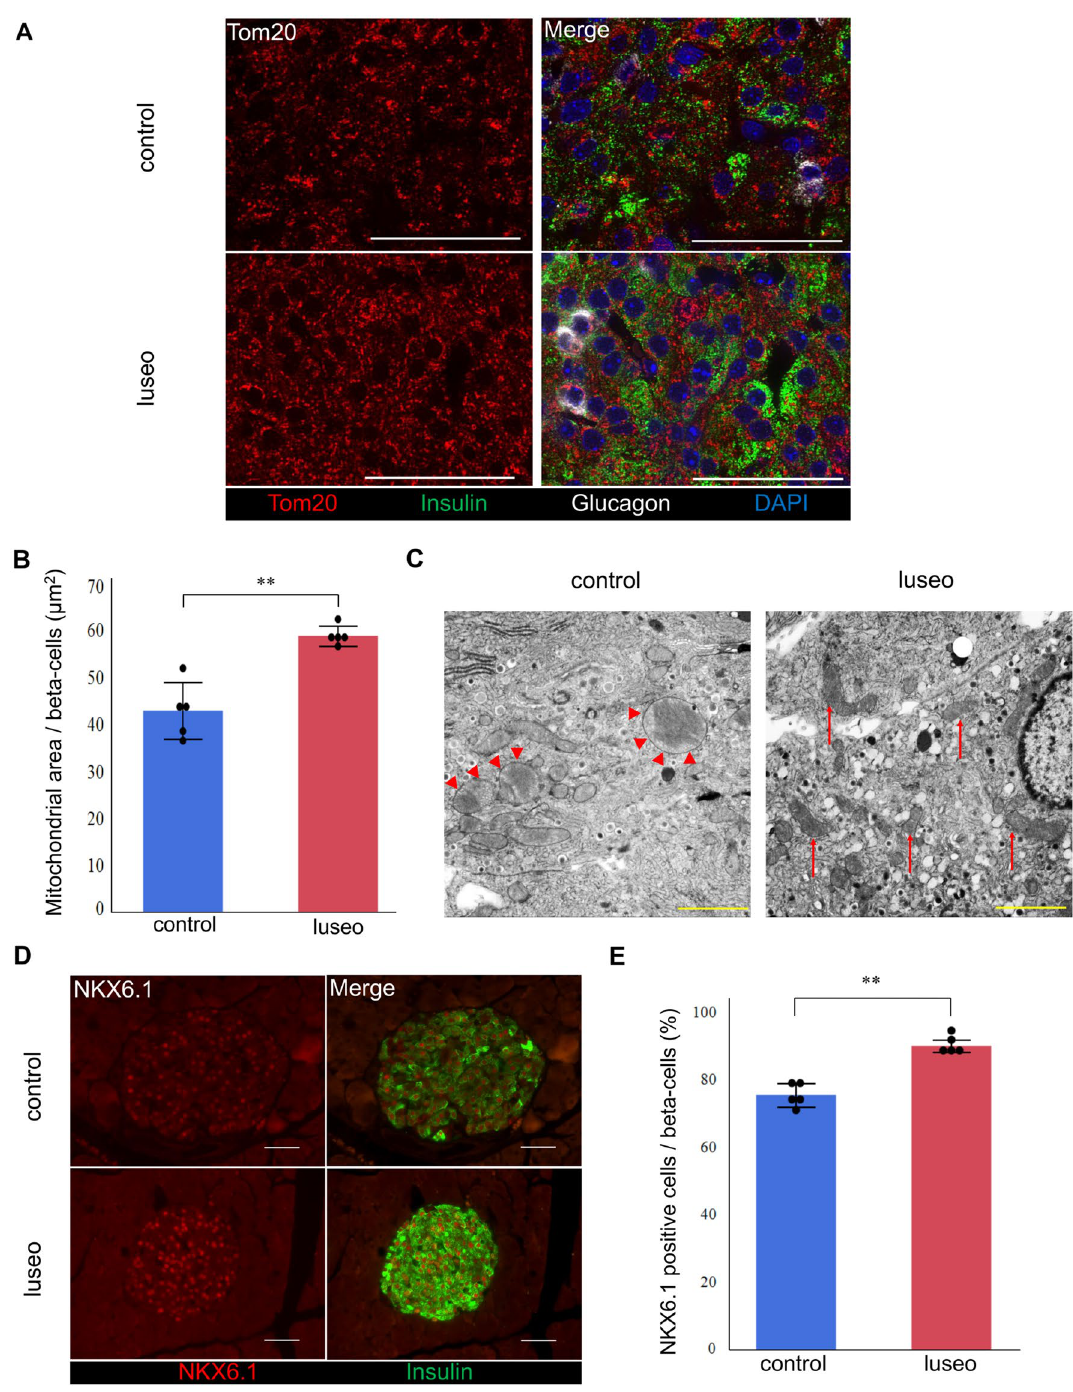
Figure 4. Effects of luseogliflozin on the mitochondrial morphology and NKX6.1 expression in the pancreatic beta-cells of 10-week-old db/db mice. ( A ) Images of pancreatic beta-cells from the control and luseo groups stained with Tom 20 (mitochondria, red), insulin (green), glucagon (white), and DAPI (nucleus, blue). Scale bars: 50 µm. ( B ) Mitochondrial area in the pancreatic beta-cells ( n = 5). ( C ) Electron microscopic analysis of pancreatic beta-cells. Red arrowhead: swelling of mitochondria, red arrows: normal mitochondria. Scale bars: 2 µm. ( D ) Images of pancreatic beta-cells from the control and luseo groups, stained for NKX6.1 (red) and insulin (green). Scale bars: 50 µm. ( E ) Ratio of the number of NKX6.1 and insulin double-positive (co-staining) cells to the total number of insulin positive (beta) cells (%) ( n = 5). Values are mean ± SD. P values were determined using Student’s t test. ** P <